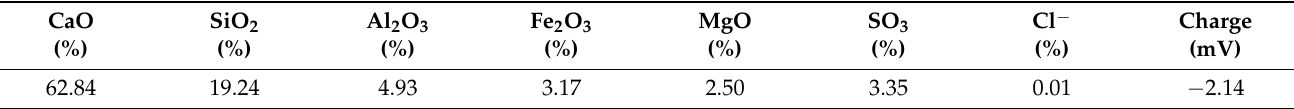
Table 4. Portland cement characteristics (average